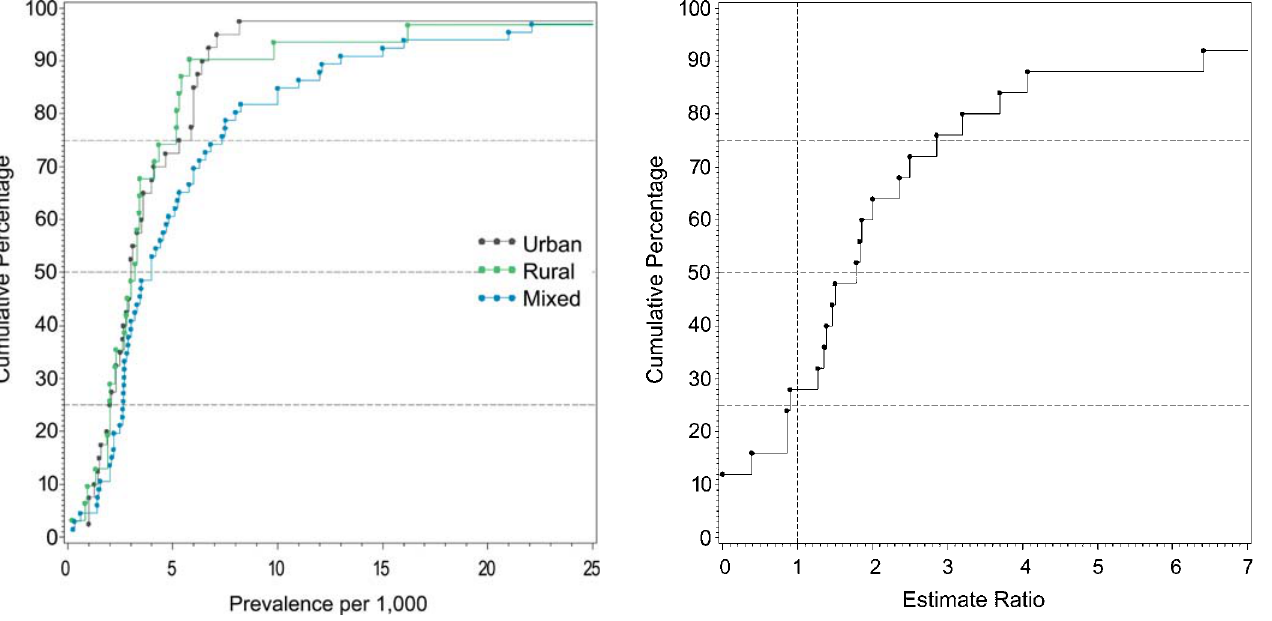
Figure 10. Cumulative Plots of Combined Prevalence Estimates per 1,000 for Persons by Urbanicity DOI: 10.1371/journal.pmed.0020141.g010